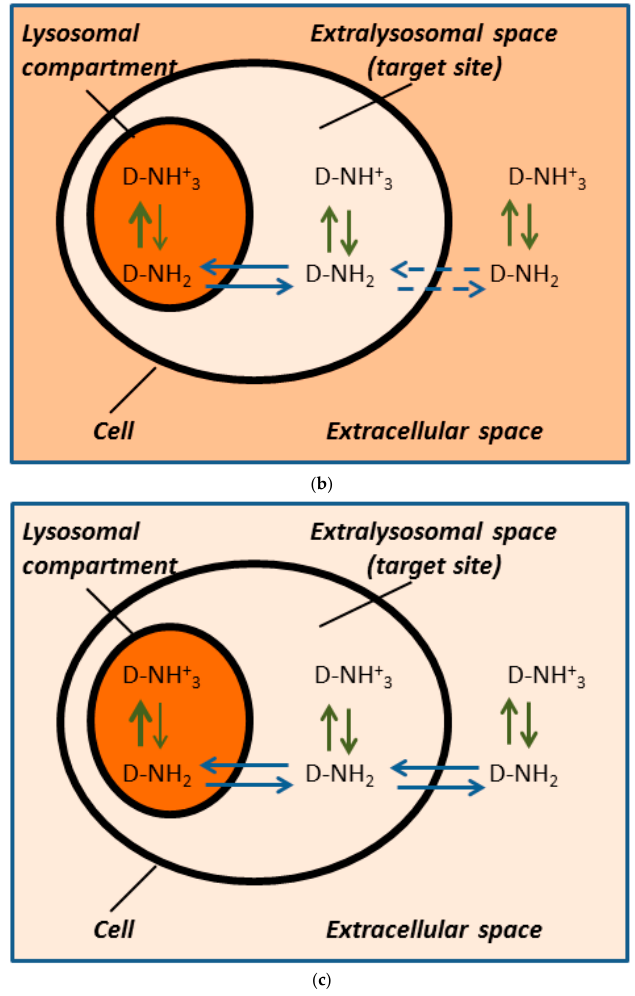
Figure 1. Weak-base drug distribution within the cell in vitro. Our model includes several theoretical assumptions: (i) uncharged forms of weakly basic drugs can freely diffuse across cellular membranes [5,20]; (ii) only two interactions are considered, the Henderson–Hasselbach equilibrium ↑ ↓ and the passive diffusion of uncharged molecules ↔ ; (iii) the extra and intracellular (extralysosomal space) pHs are equal. Color saturation corresponds to the drug concentration. ( a ) Drug distribution without lysosomal sequestration. (This may occur, for example, after the addition of BafA1, a vacuolar ATPase inhibitor.) Uncharged molecules can freely diffuse across cell membranes. ( b ) Drug distribution with lysosomal sequestration. Uncharged molecules can freely diffuse only across the lysosomal membrane. Under such conditions, the lysosomal sequestration of a drug can dramatically reduce its extralysosmal concentration (drug concentration at target sites), and thus mediate drug